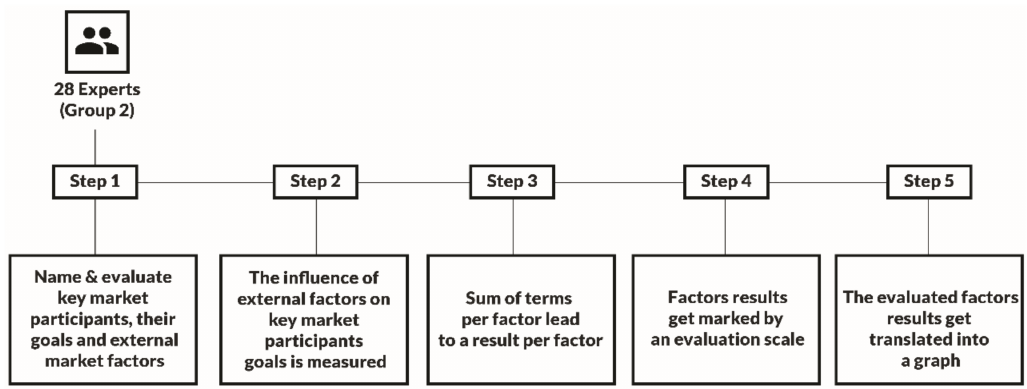
Figure 4. Summary of various steps for methodology applied (Multiple-criteria decision